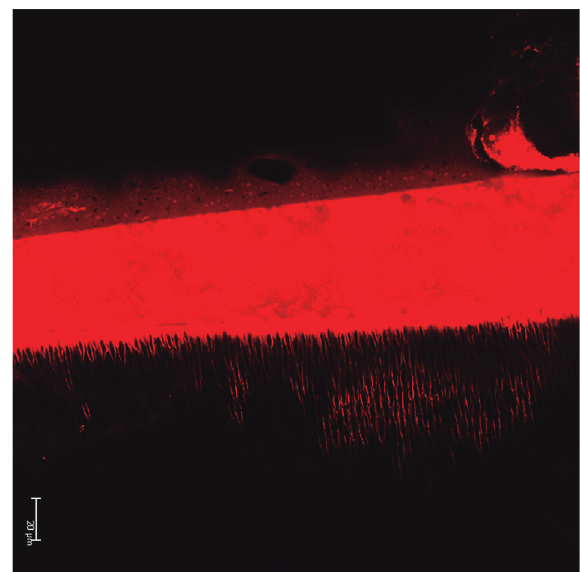
Figure 6b- Interface aspect of bonding system to enamel surface eroded by Light Coke (LC) followed by toothbrushing. Hybrid layer is also superficial, but much more regular than only eroded surface